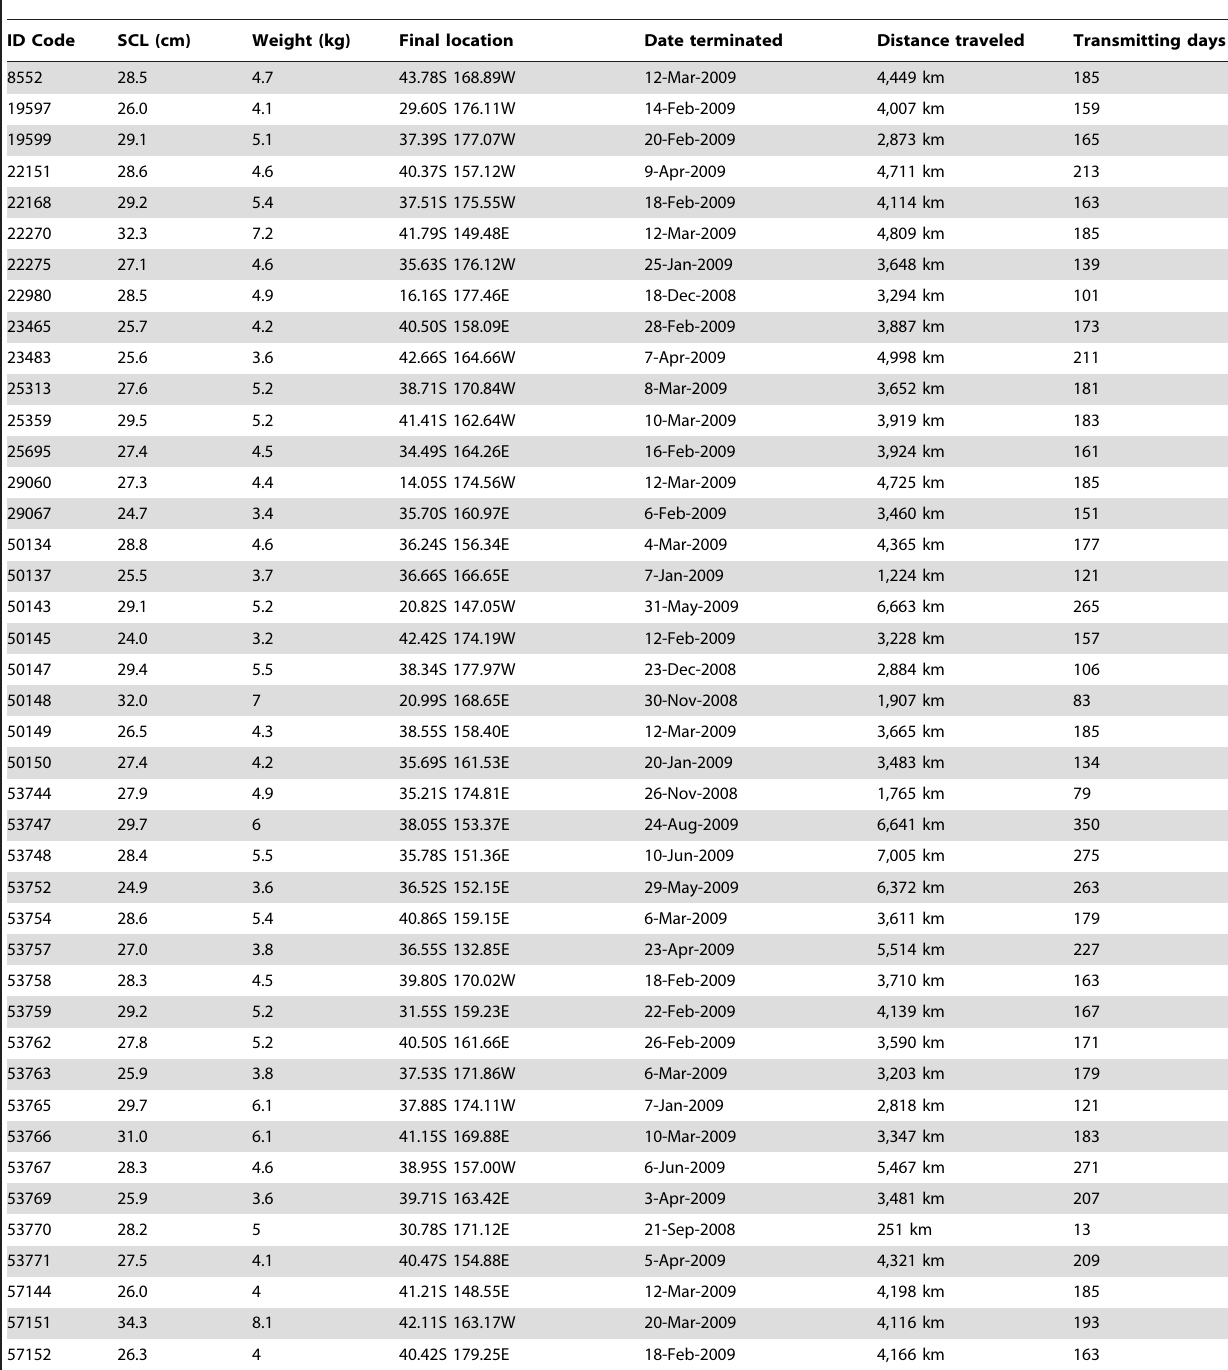
Table 1. Summary of satellite tag information for 42 juvenile loggerhead turtles released off New Caledonia on 9-September-2008.